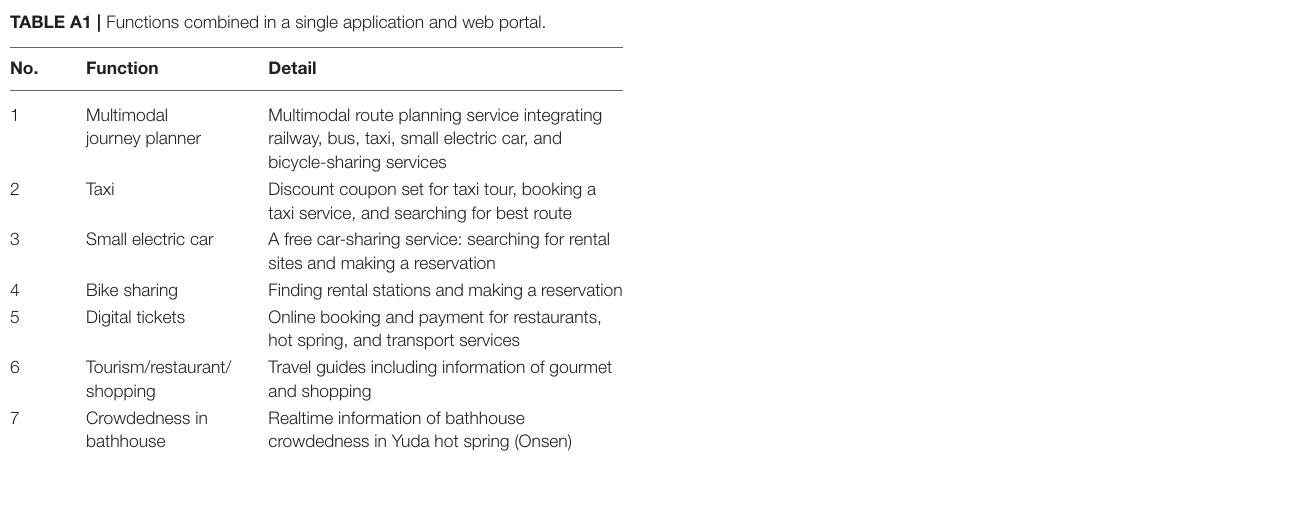
Frontiers in Sustainable Cities |